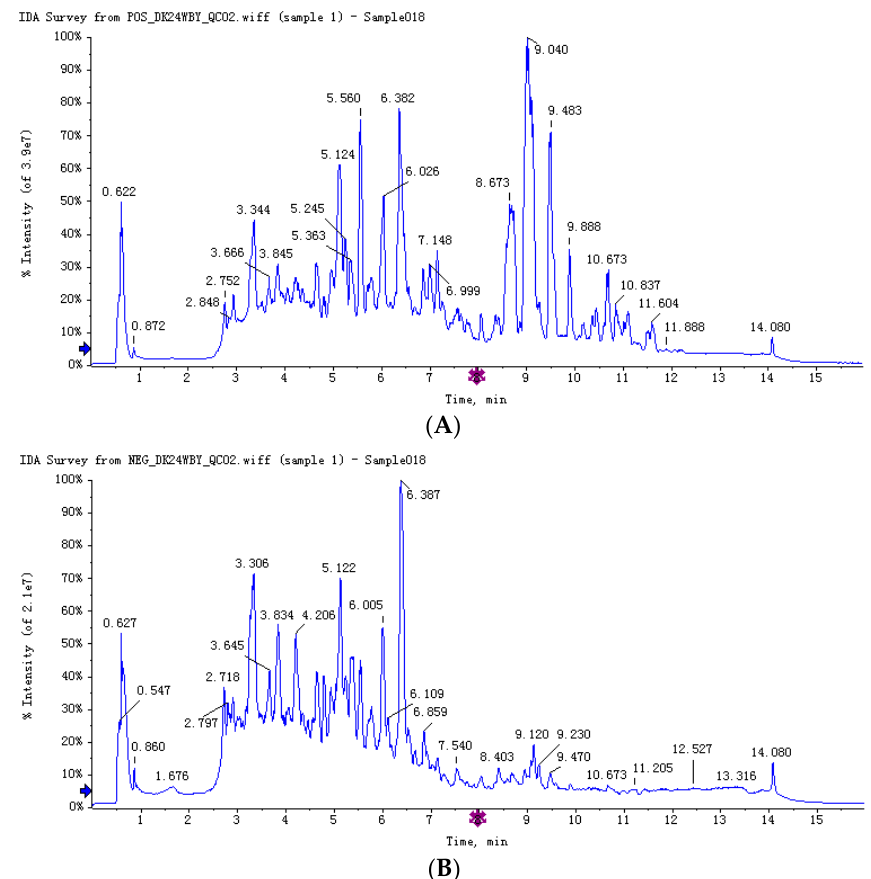
Figure 1. The total ion chromatograms of quality-control samples in positive and negative ion modes. ( A ) Total ion chromatographic in cationic mode (positive ion); ( B ) total ion chromatographic in anionic mode (negative ion).